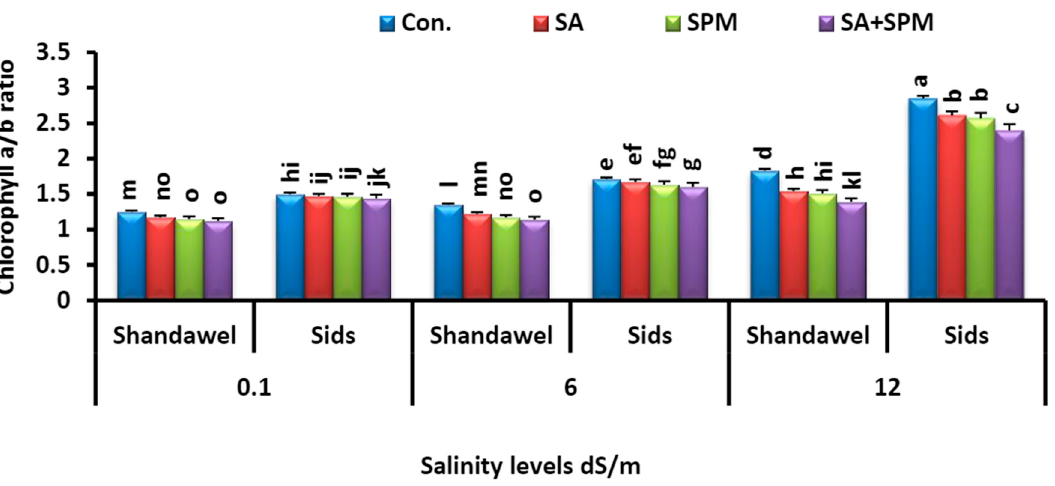
Figure 4. Influence of salicylic acid (SA; 100 mgL − 1 ) and/or spermine (SPM; 30 mgL − 1 ) on the chlorophyll a / b ratio in leaves of two wheat cultivars (Shandawel 1 and Sids 14) grown under 0.1, 6, and 12 dS m − 1 salinity levels. Data are mean of four replicates (n = 4). Different letters indicate significant differences at ( p < 0.05) level, according to Duncan’s test.